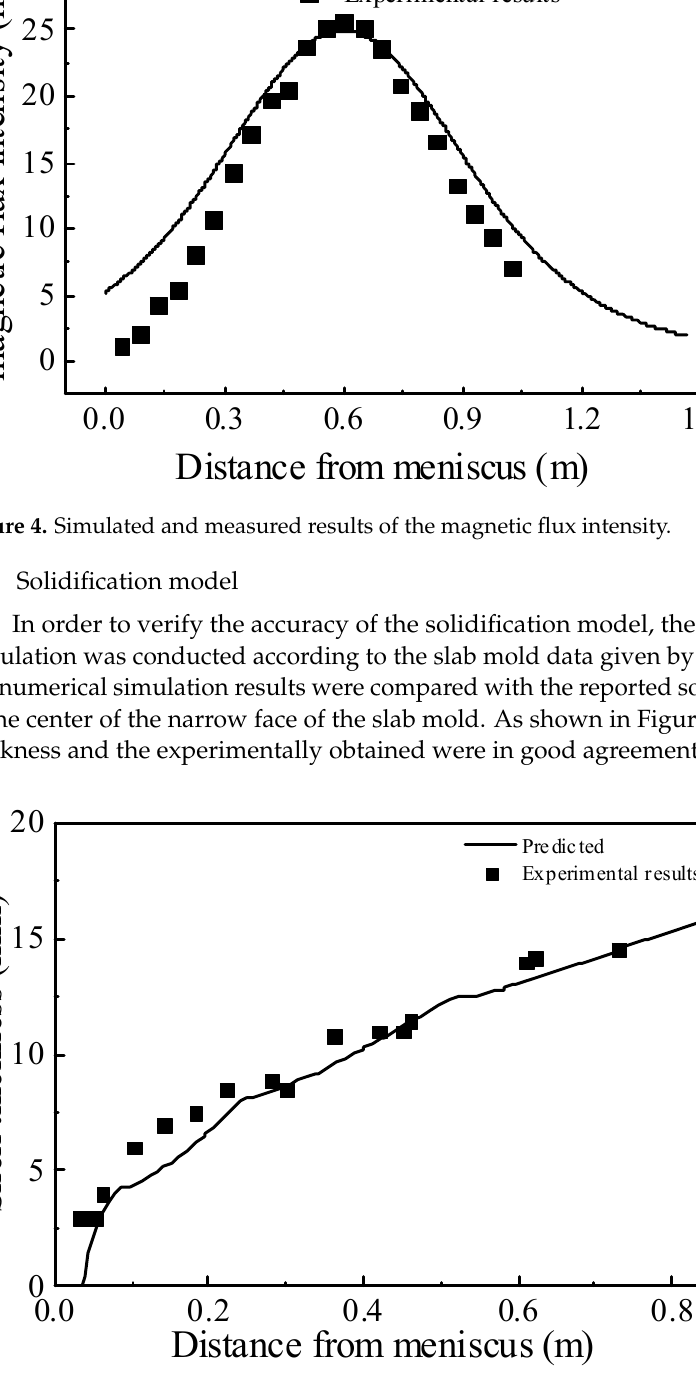
Figure 5. Validation of solidification model. Figure 6 depicts the velocity contours and streamlines on the plane Y = 0 m without M-EMS. The liquid steel enters the mold through the SEN and directly impacts the initially solidified shell, and forms two longitudinal circulations. In the upper circulation, the molten steel moves upward along the solidification front and extends to the